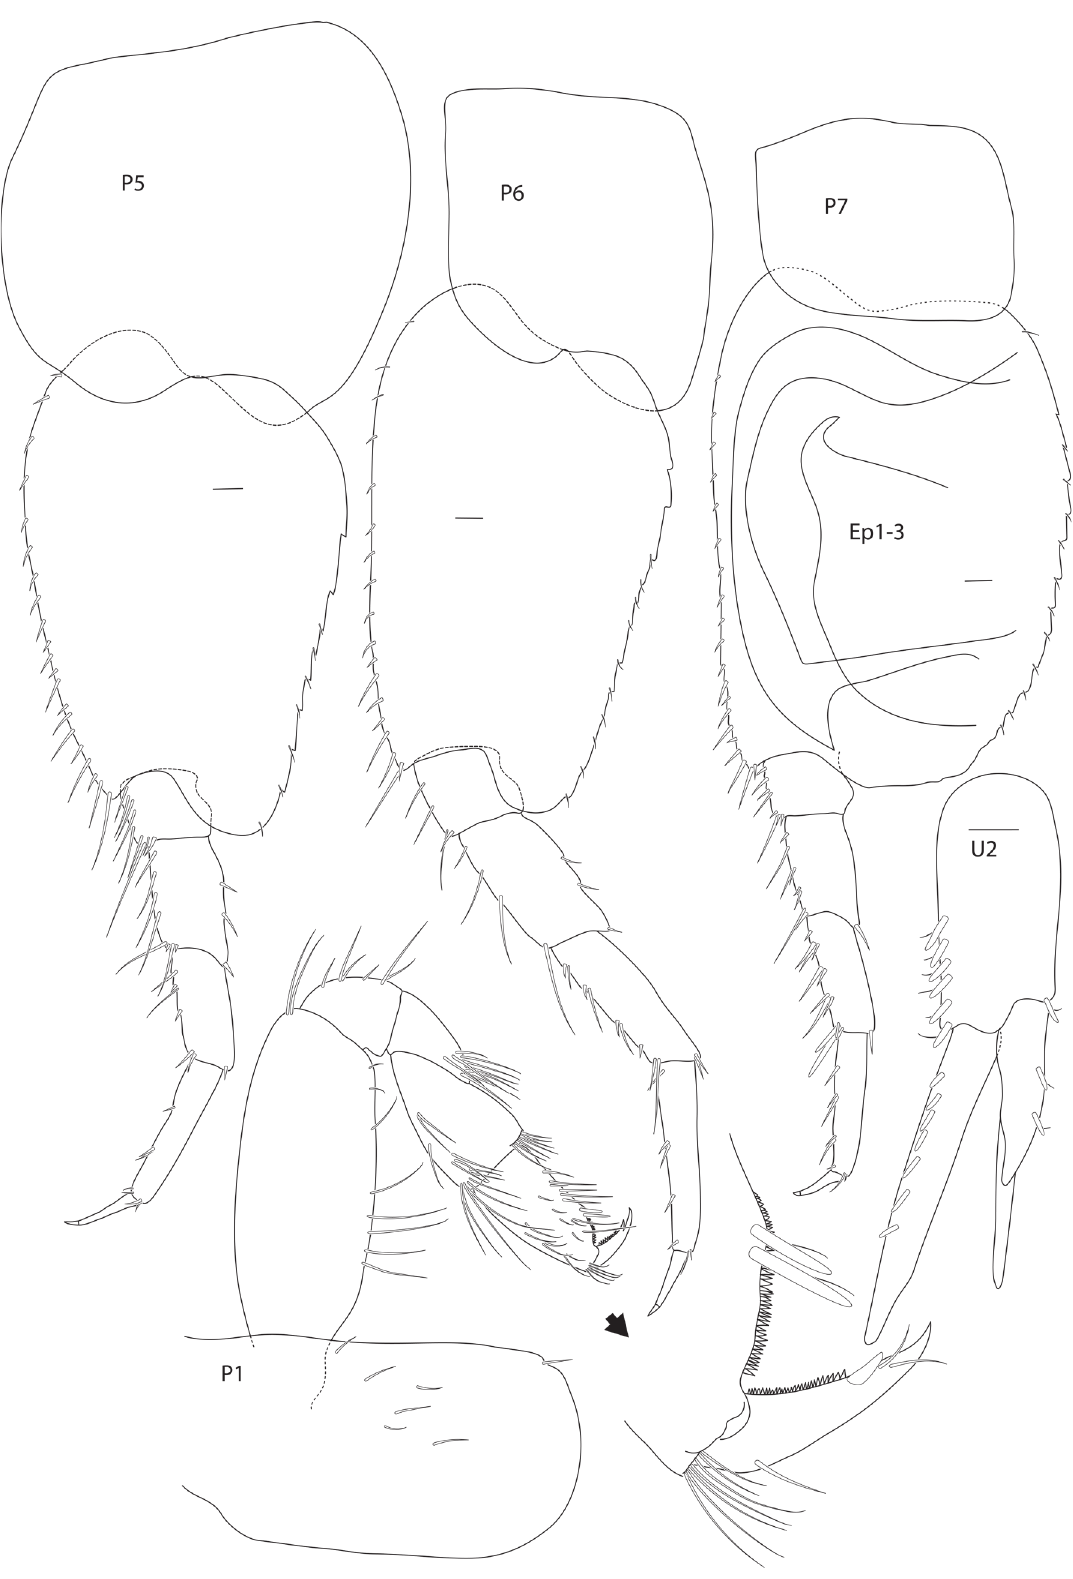
Fig. 3. Onisimus normani Sars, 1890, ♀, 10 mm, Korsfjorden, Norway (TSZCr8659). Pereopods 1, 5, 6 and 7, uropod 2, epimeral plates 1–3. Abbreviations: see Material and methods. Scale bars = 0.1